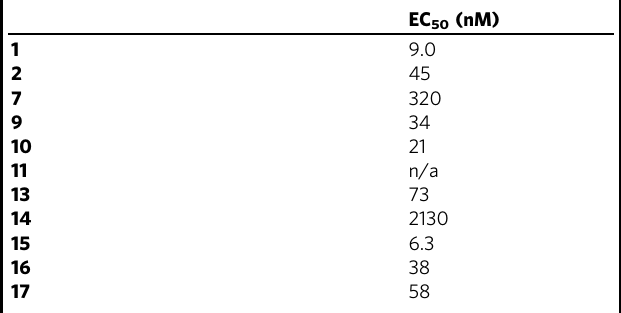
Table 1 Biological activities of rapamycin and its derivatives to induce the formation of FKBP-mTOR